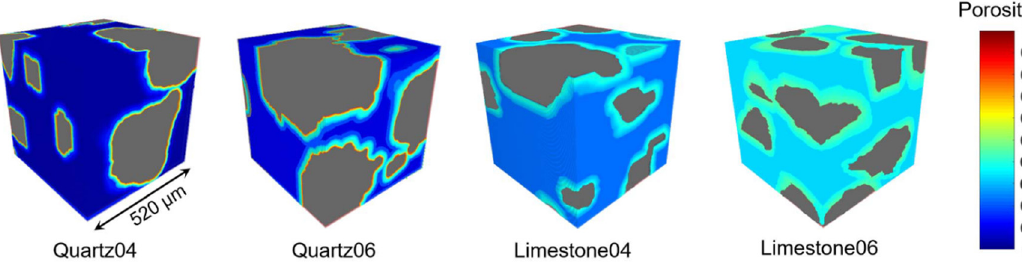
Figure 5: 3D microstructure of ITZ ( quartz and limestone as aggregates, w/c ratios of 0.4 and 0.6, respectively ) [ 48 ]